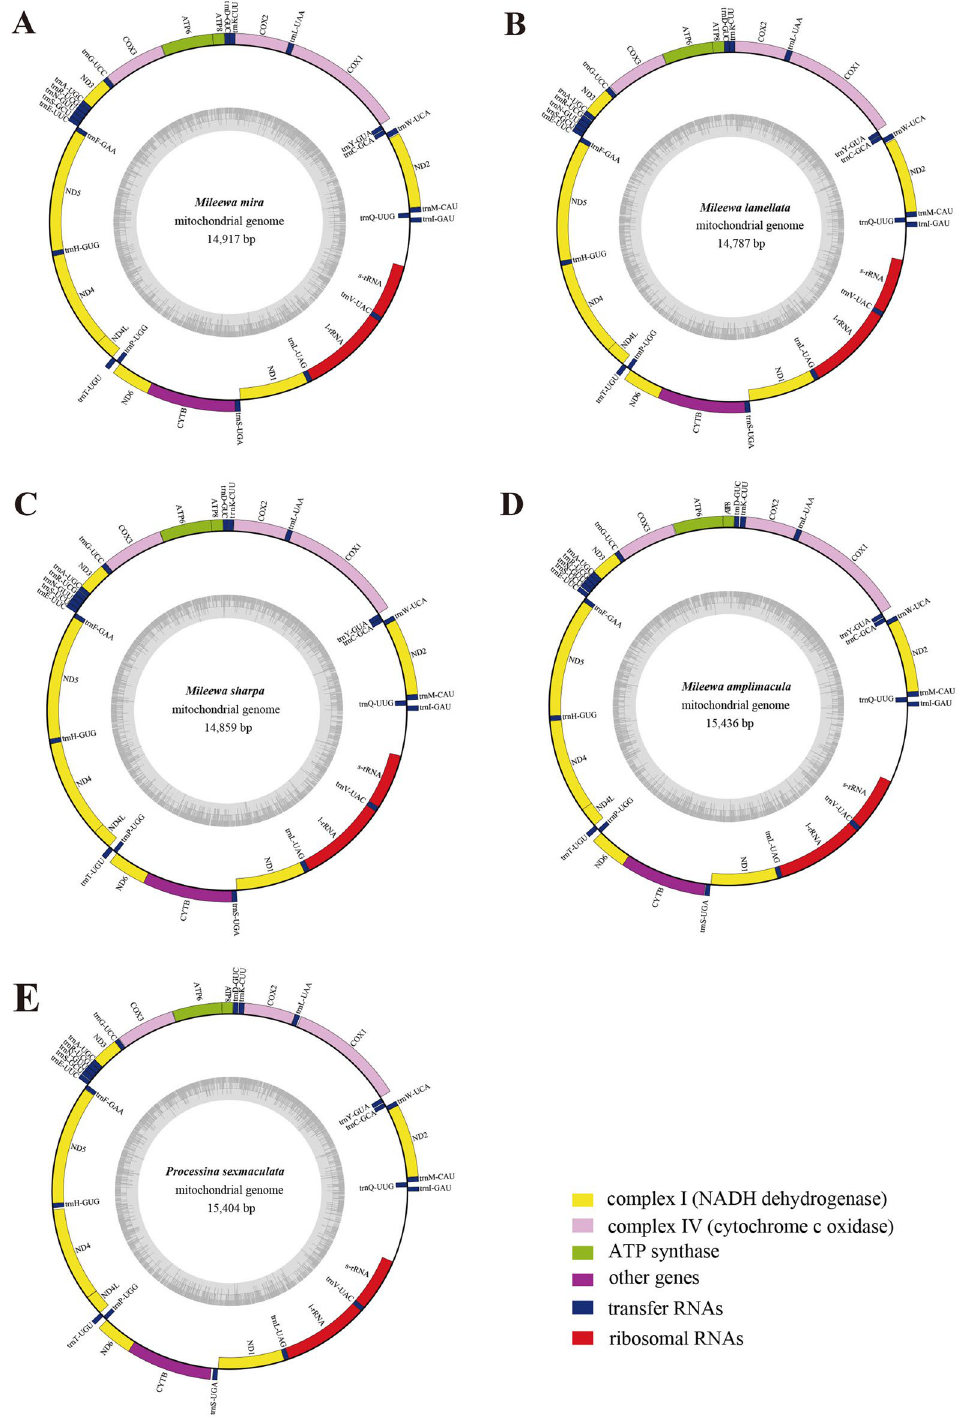
Figure 1. Circular maps of the mitogenomes of Mileewa mira ( A ), Mileewa lamellata ( B ), Mileewa sharpa ( C ), Mileewa amplimacula ( D ), and Processina sexmaculata ( E ). Genes are shown in different color blocks. Color blocks outside the circle indicates that the genes are located on the heavy strand (H-strand); color blocks within the circle indicates that the genes are located on the light strand